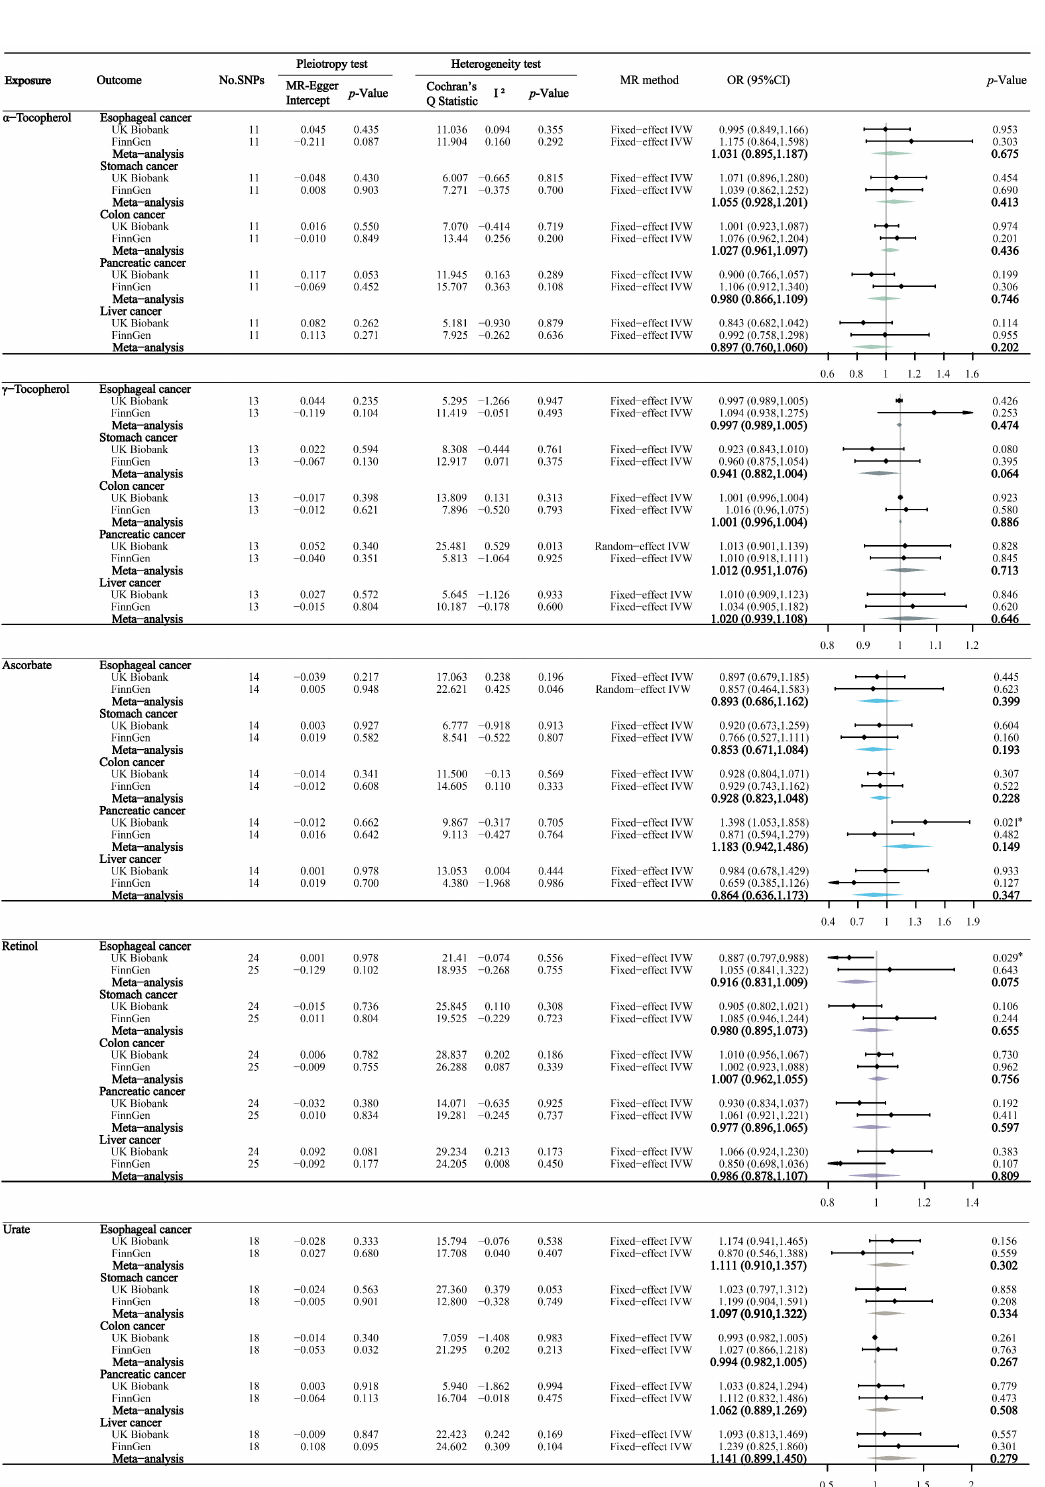
Figure 3. The main MR analyses results of the causal effects of circulating antioxidant metabolites on five digestive system cancers. If there was significant heterogeneity ( p -value of Cochran (cid:48) s Q Statistic < 0.05), we used the random-effect IVW model, otherwise we used the fixed-effect IVW model. The odds ratios were scaled per 10% unit increase in log-transformed α -tocopherol, γ - tocopherol, and urate values, and per unit increase in log-transformed ascorbate and retinol values. Statistical significance was defined as Bonferroni-corrected threshold of p -value < 0.01 (0.05/5), and p -value between 0.01 and 0.05 was considered suggestive evidence (*) of